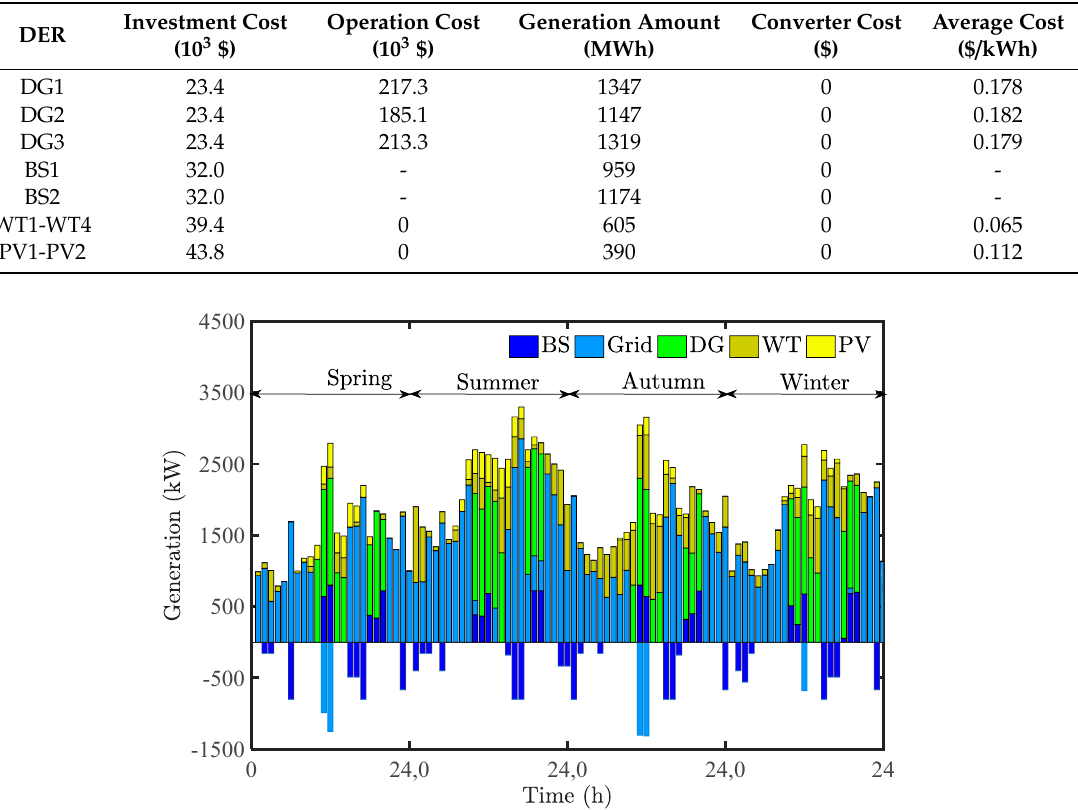
Table 7. Annual Cost and Generation of DERs in the MG.